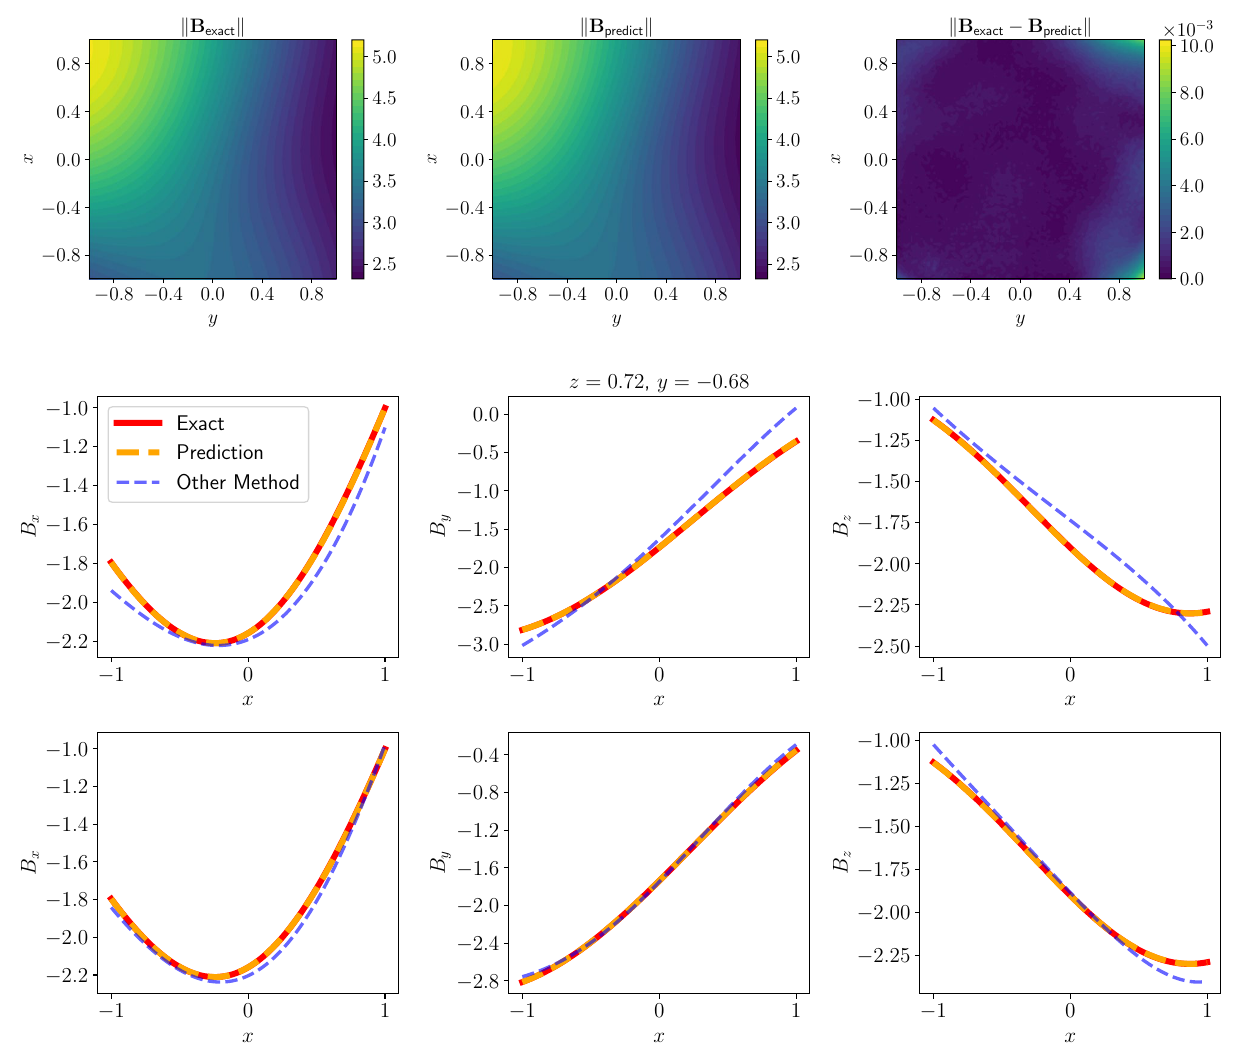
Figure 4. Top: Magnitude plot of the predicted magnetic field along with exact magnetic field and the error at snapshot z = 0.72 , middle: comparison of the predicted and the other method’s solutions’ x , y , z directions with 18 sensor data, bottom: comparison of the predicted and the other method’s solutions’ x , y , z directions with 30 sensor